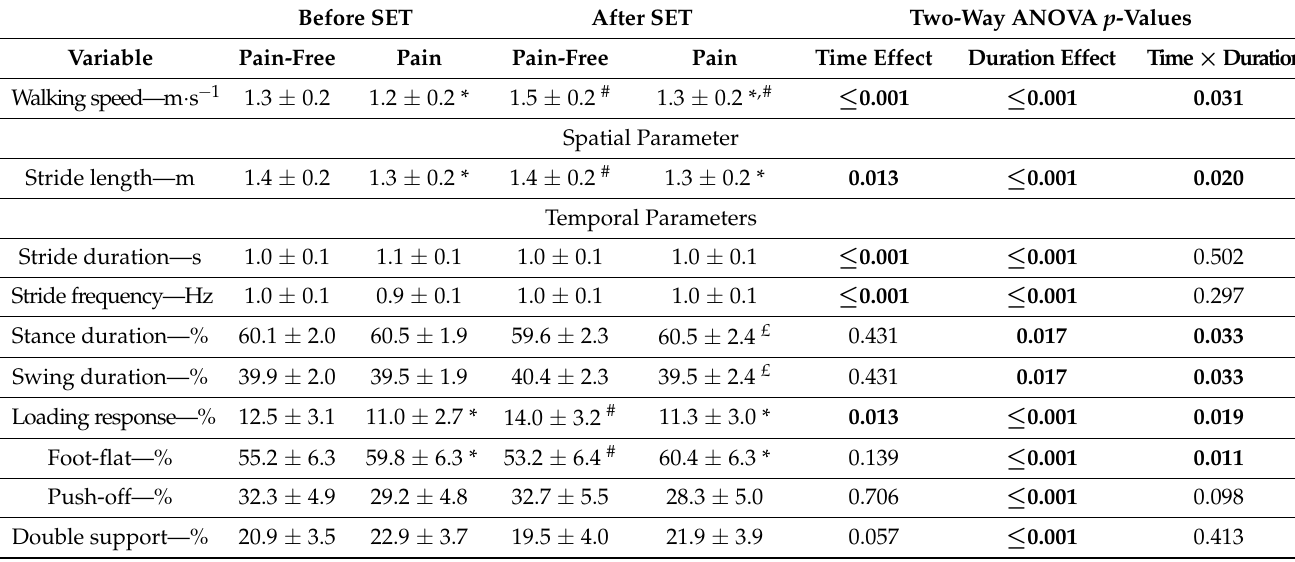
Table 3. Spatiotemporal gait parameters in the most symptomatic leg during the 6 min walk test before and after supervised exercise training